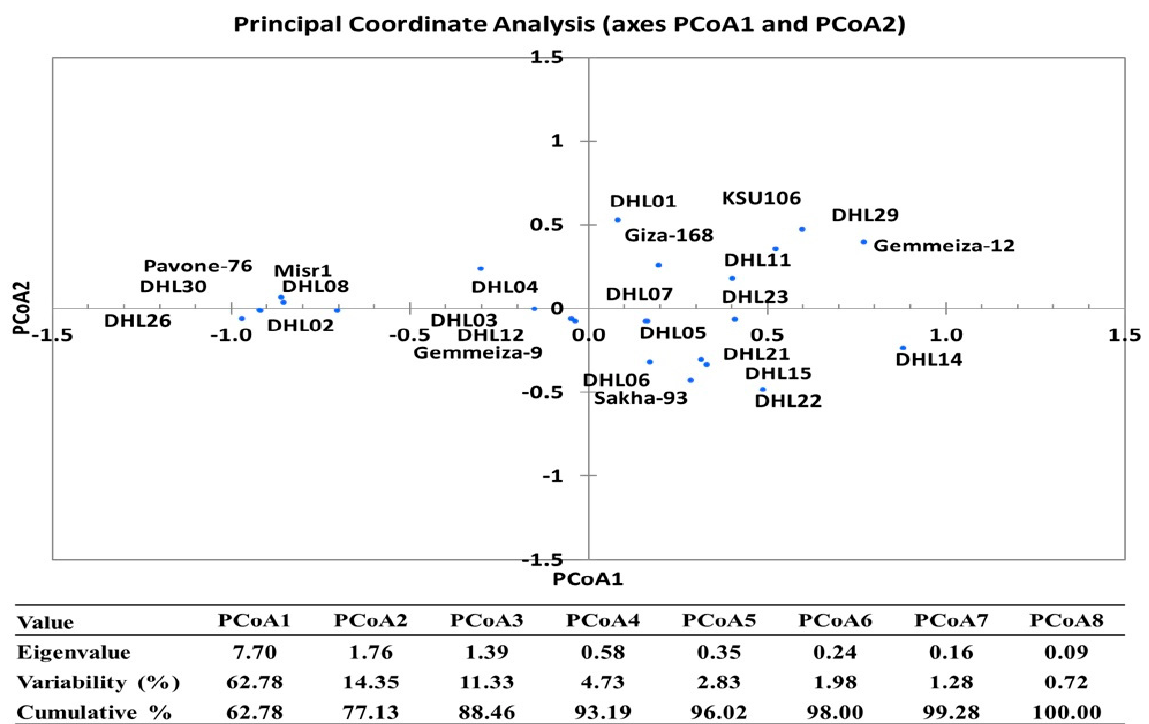
Figure 3. Principal coordinates analysis (PCoA) among the 25 wheat genotypes based on the Euclidean distance dissimilarity.